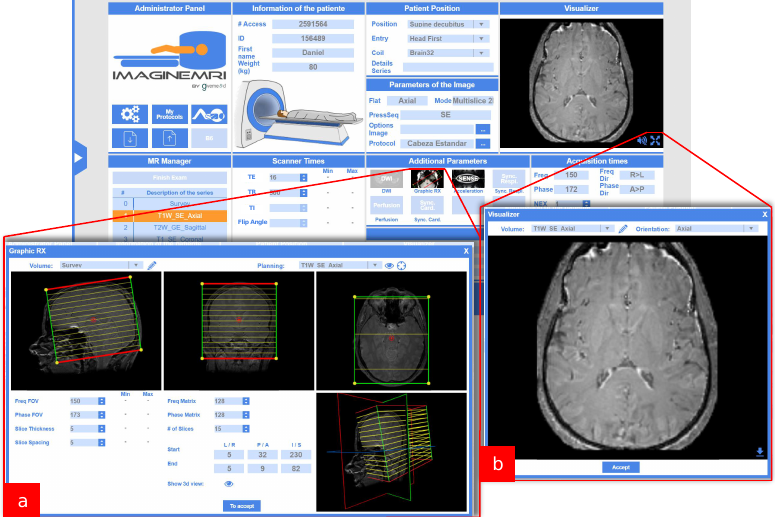
Figure 2. Web-based MRI Simulator. Image of the main panel of the simulator and two pop-up panels: ( a ) The panel for the location of the slices and ( b ) the viewer of the images obtained.